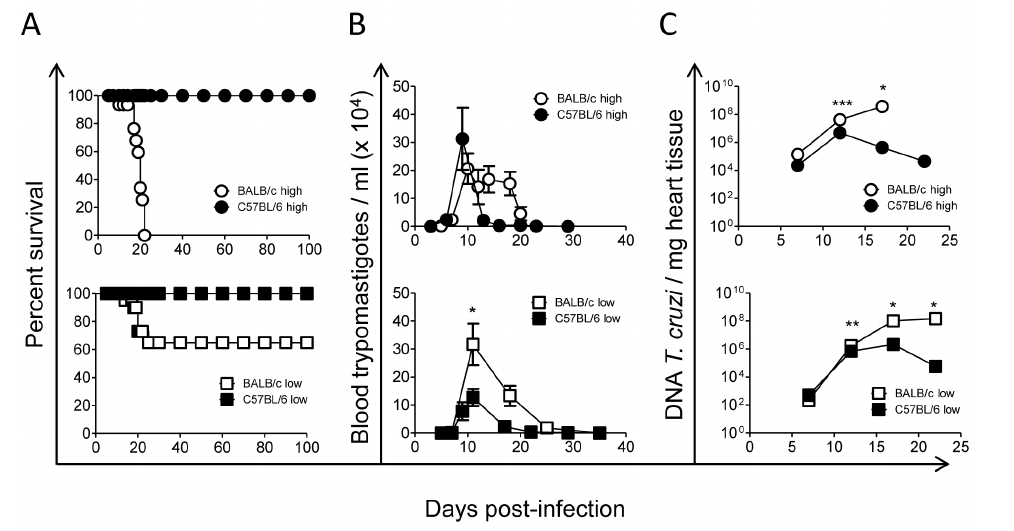
Figure 1. BALB/c mice infected with T.cruzi showed higher parasite loads and lower survival rates than infected C57BL/6 mice. BALB/ c mice were infected with high inoculum (open circle) or low inoculum (open square). C57BL/6 mice were infected with high inoculum (filled circle) or low inoculum (filled square). ( A ) Survival was monitored from 0 to 100 d.p.i., ( B ) parasitemia was monitored from 0 to 35 d.p.i., and ( C ) the parasite load in heart tissue was determined at 7, 12, 17 and 22 d.p.i. in mice infected with high inoculum (top) or low inoculum (bottom) by extrapolation with parasite DNA standards. Data represent the results of at least two independent experiments performed with 3 mice per experimental group. Statistically significant differences between BALB/c and C57BL/6 mice are shown: * p , 0.05, ** p , 0.01 and *** p , 0.001.